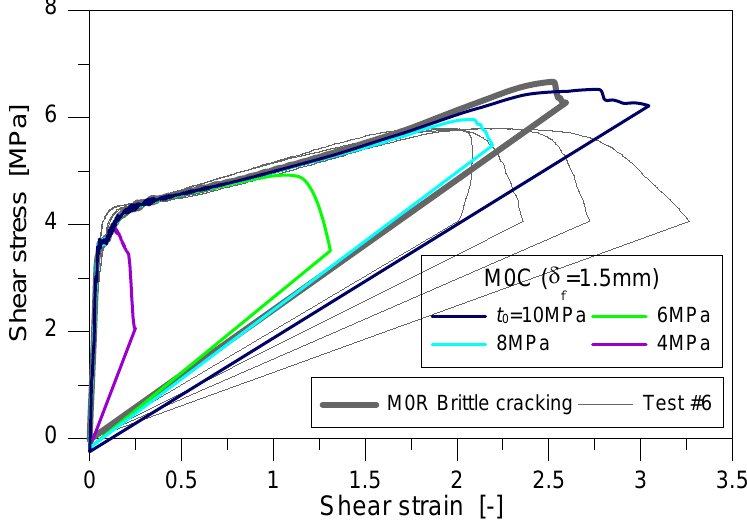
Fig. 6 Comparative numerical assessment of the M0C model (ABAQUS), with respect to earlier studies (Pravdová et al., 2016), as a function of CZM resistance t 0 .